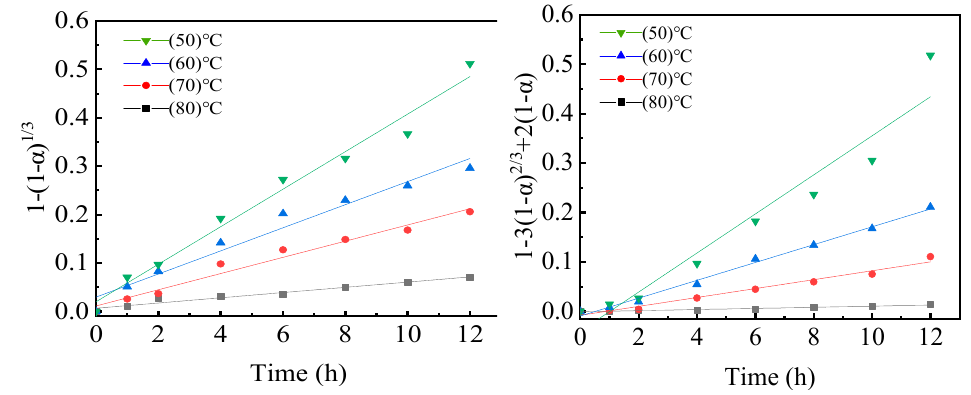
Figure 10. Kinetic model fitting curves of mechanically activated samples at different reaction temperatures.